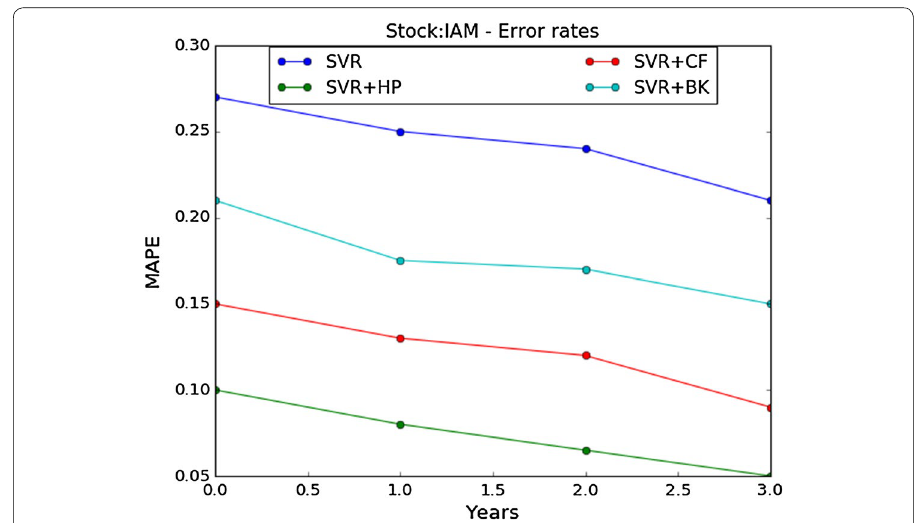
Fig. 7 MAPE (Error rate) of the predictive models